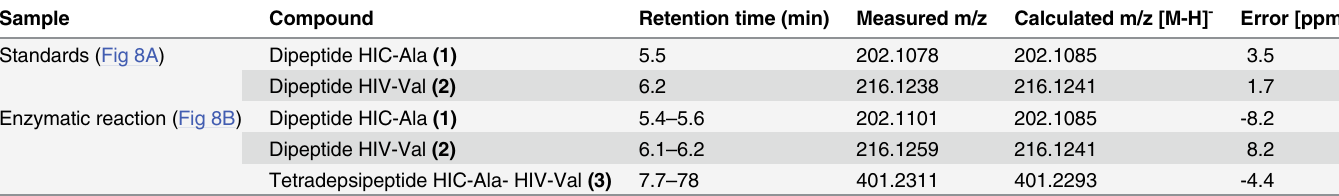
Table 2. MS analysis of the peptide synthesis reaction of in vitro- reconstituted cereulide synthetase.